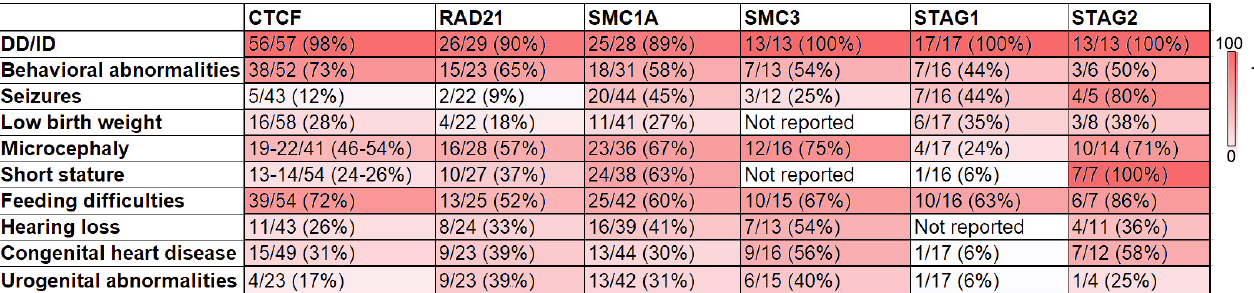
Figure 4. Prevalence of reported human phenotypes for patients with variants in CTCF or cohesin subunits. Color intensity represents the percentage of reported cases. Numbers are gathered from publicly available information from the following sources: [71,72] for CTCF; [94] for RAD21; [100]